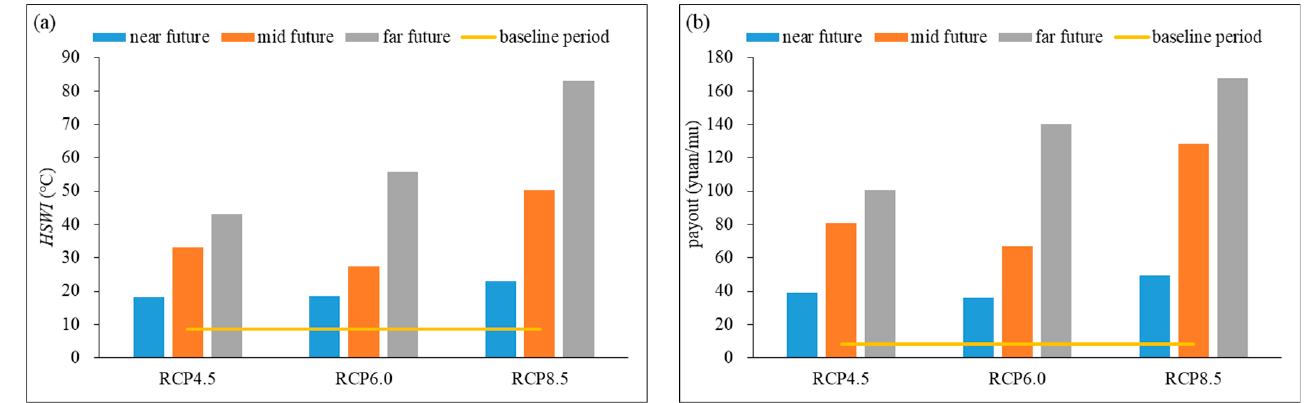
Figure 7. HSWI ( a ) and payout ( b ) due to rice heat stress in different periods from 2021 to 2099 under 3 RCPs in the area south of the Huai River in Anhui Province.